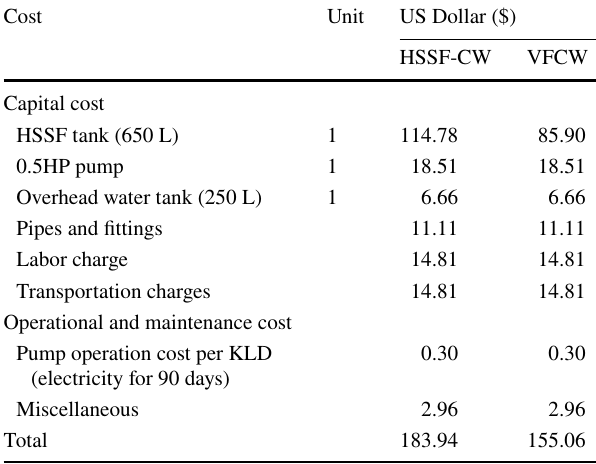
Table 3 Cost analysis of the pilot-scale model HSSF-CW and VFCW during the study period from February 14, 2018, to May 15,